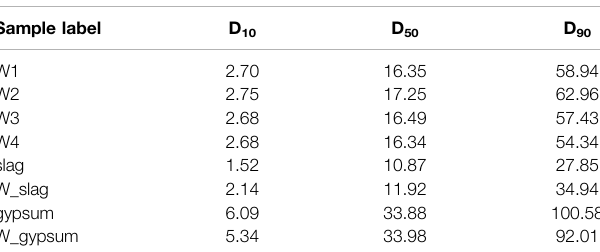
TABLE 3 | Characteristic particle size parameter of P-SSC pastes.